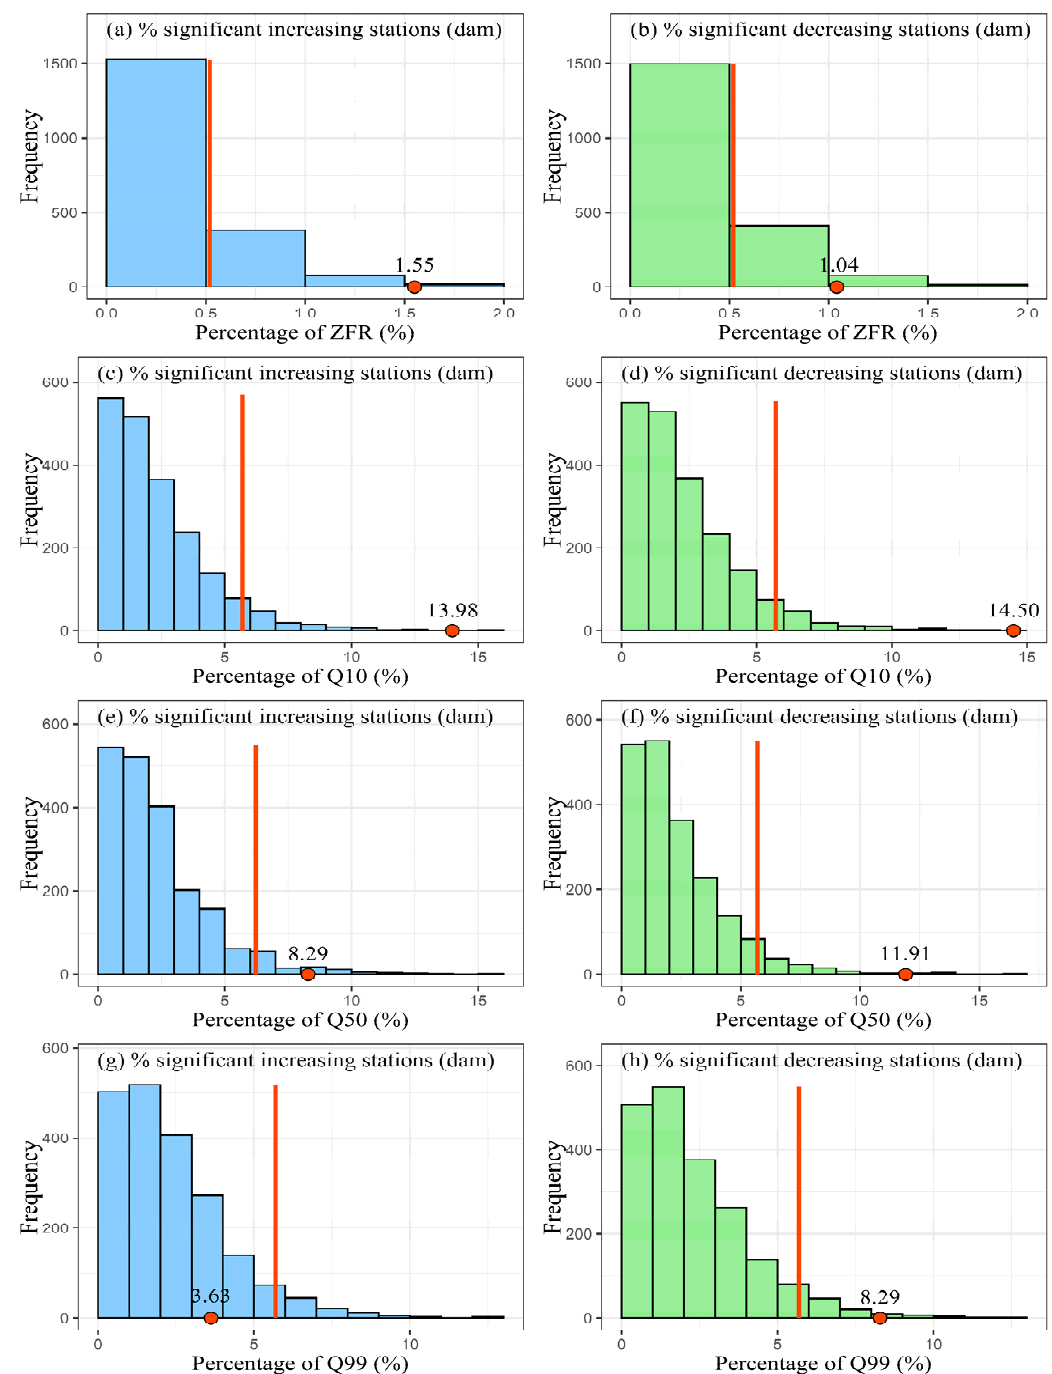
Figure 7. The proportion of stations with significant trends for 193 stations in the “dam” dataset on the four runoff signatures, i.e., ( a , b ) ZFR, ( c , d ) Q10, ( e , f ) Q50, ( g , h ) Q99, based on the Mann–Kendall test. Left panels indicate the results for the proportion of stations showing a significantly increasing trend, while right panels represent results for the proportion of stations showing a significantly decreasing trend. The histogram represents the distribution of proportion obtained from the 2000 moving-blocks field significance resampling procedure. The red dot indicates the observation value while the red line indicates the 95th percentile.